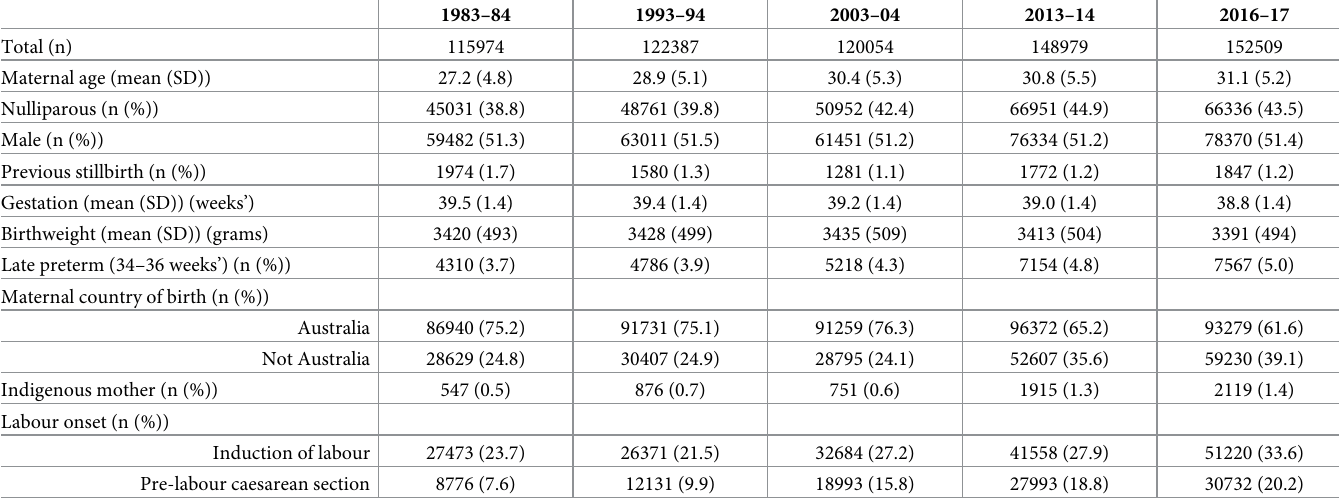
Table 1. Population characteristics in each two-year epoch for babies born between 34 and 42 weeks’